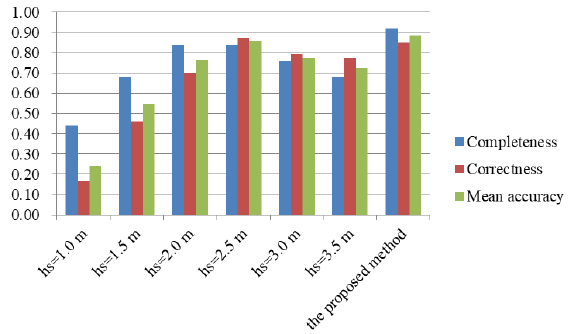
Figure 6 . The comparison results of the traditional mean shift method with different horizontal bandwidths and the proposed